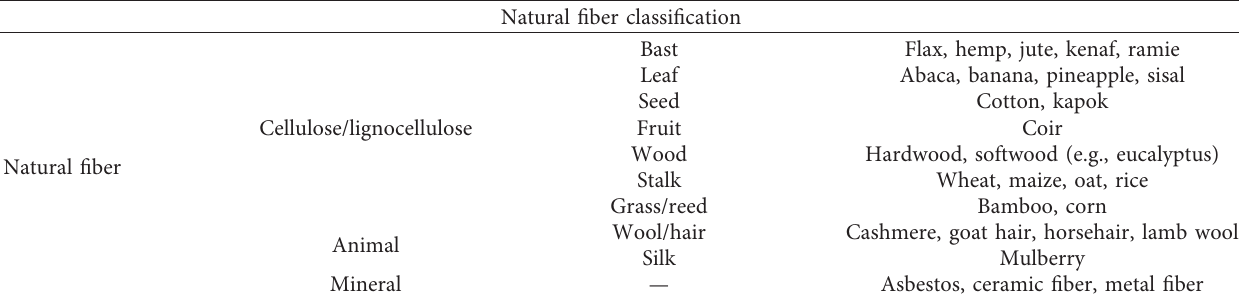
Table 1: Natural fiber classification